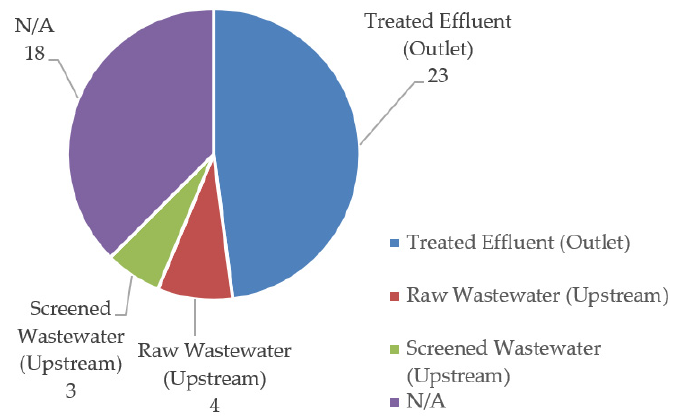
Figure 5. Hydropower scheme location in case studies.